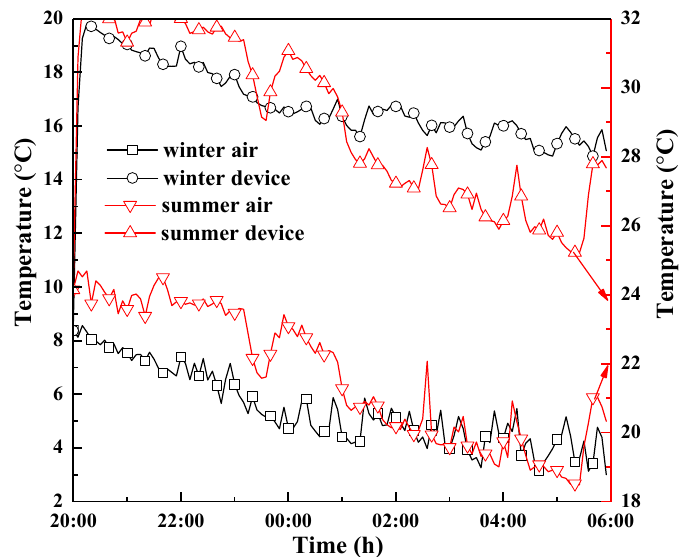
Figure 22. Time-dependent variation of the component surface temperature and ambient temperature in summer/winter nighttime (65% RH).